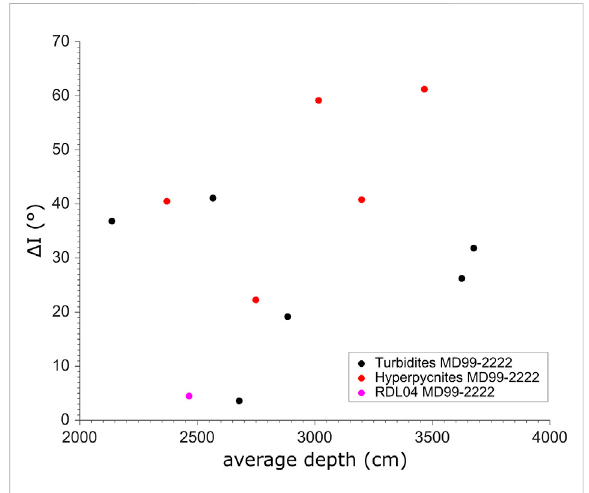
FIGURE 7 Amplitudeofinclinationchangeswithin12RDLsasafunction of their average depth in core MD99-2222. Black, red and pink closed circles are for turbidites, hyperpycnites and other RDLs from core MD99-2222, respectively.